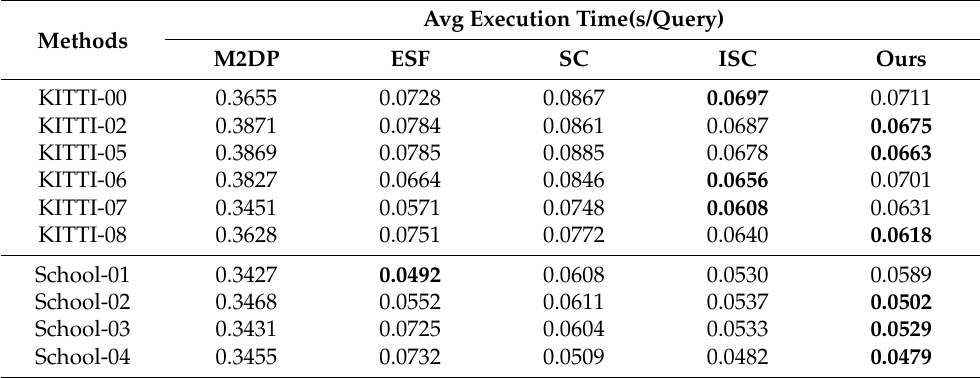
Table 3. Average execution time over KITTI dataset and JLU campus datasets.